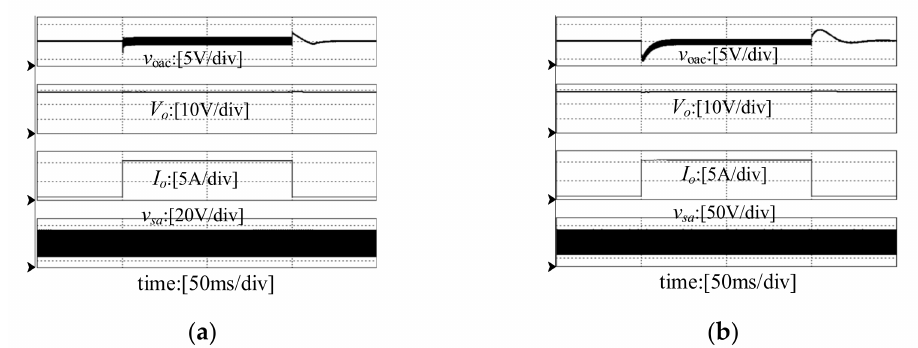
Figure 20. Simulation results of load current dynamic test. ( a ) Boost period. ( b ) Buck period.